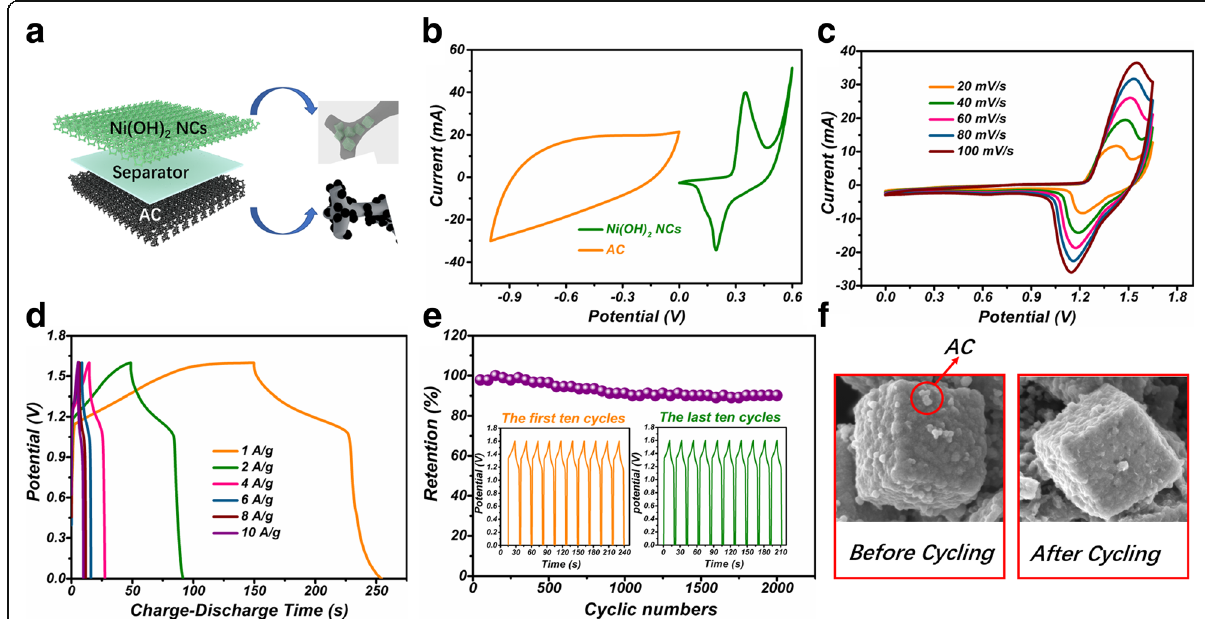
Fig. 7 a Schematic of the Ni(OH) 2 NCs/NF//AC device. b The CVs of AC and Ni(OH) 2 NCs/NF electrodes in a three-electrode system. c The CVs of Ni(OH) 2 NCs/NF//AC ASC between 0 and 1.6 V. d GCD curves of the ASC at different current densities between 0 and 1.6 V. e Cycling stability of the ASC during 2000 cycles at 4 A g − 1 . f The SEM images of the positive electrode before and after the